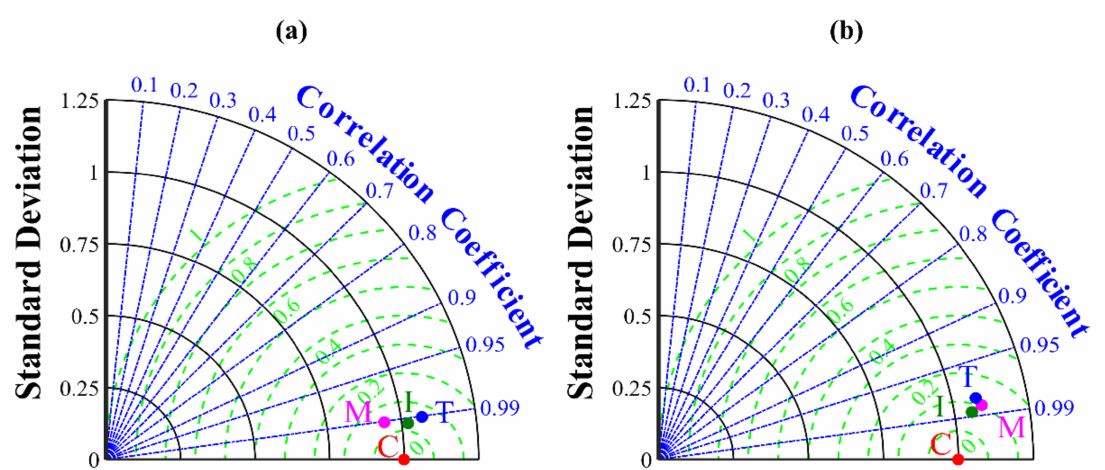
Figure 11. Taylor diagrams comparing monthly precipitation from MSWEP, TRMM, and IMERG precipitation products with respect to ground observation data for two elevation levels: ( a ) High altitude; ( b ) Low